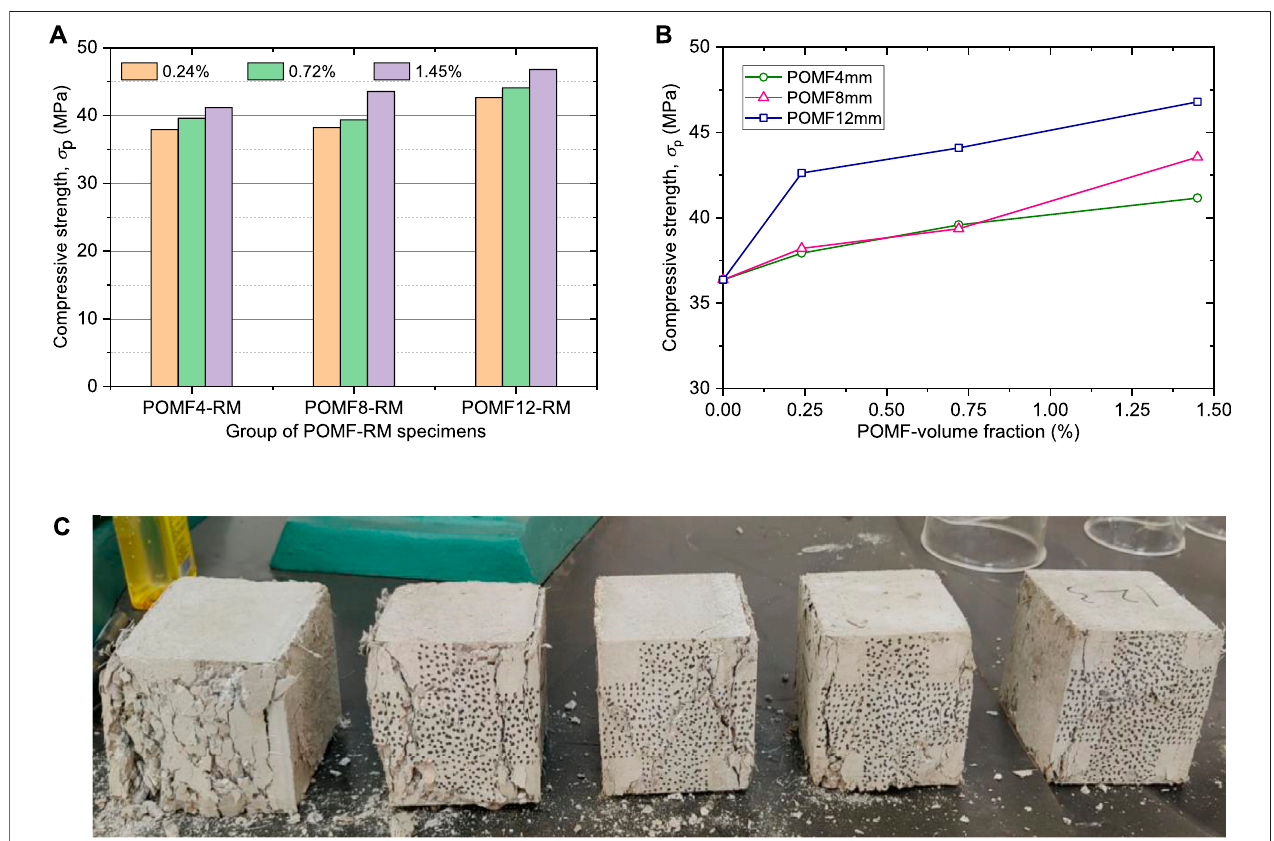
FIGURE 2 | (A) Histogram showing the compressive strength of the POMF-RM material (B) Effects of POMF volume fraction on the compressive strength of the POMF-RM material (C) A photo showing the failed mortar specimens.